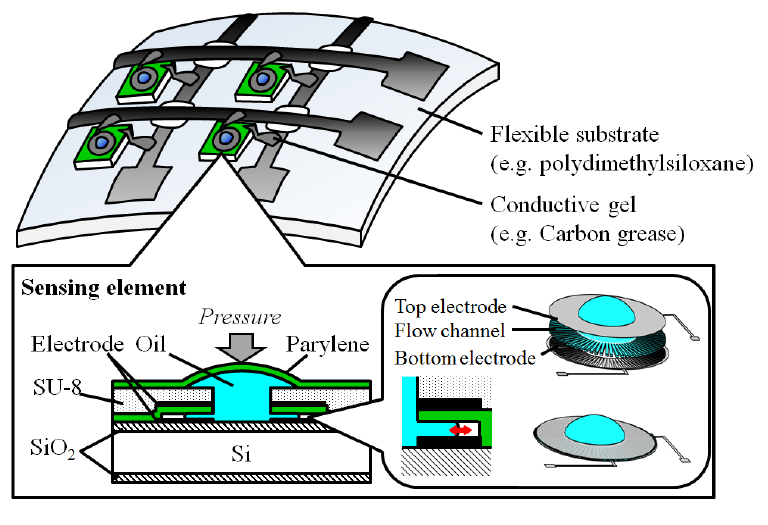
Figure 1. Schematic of flexible tactile